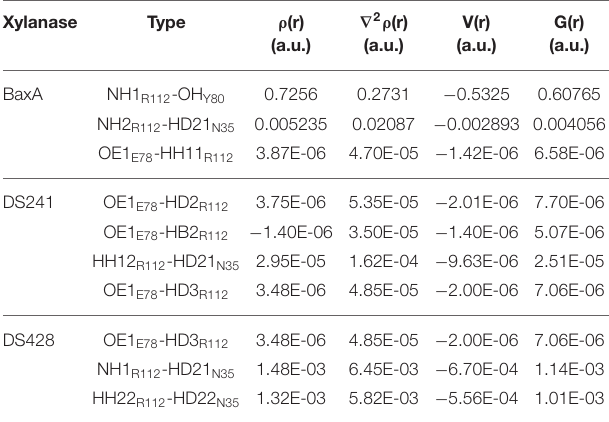
Several BCPs among R112/E78, R112/Y80, R112/N35 can be TABLE 3 | Comparison of the values of topological